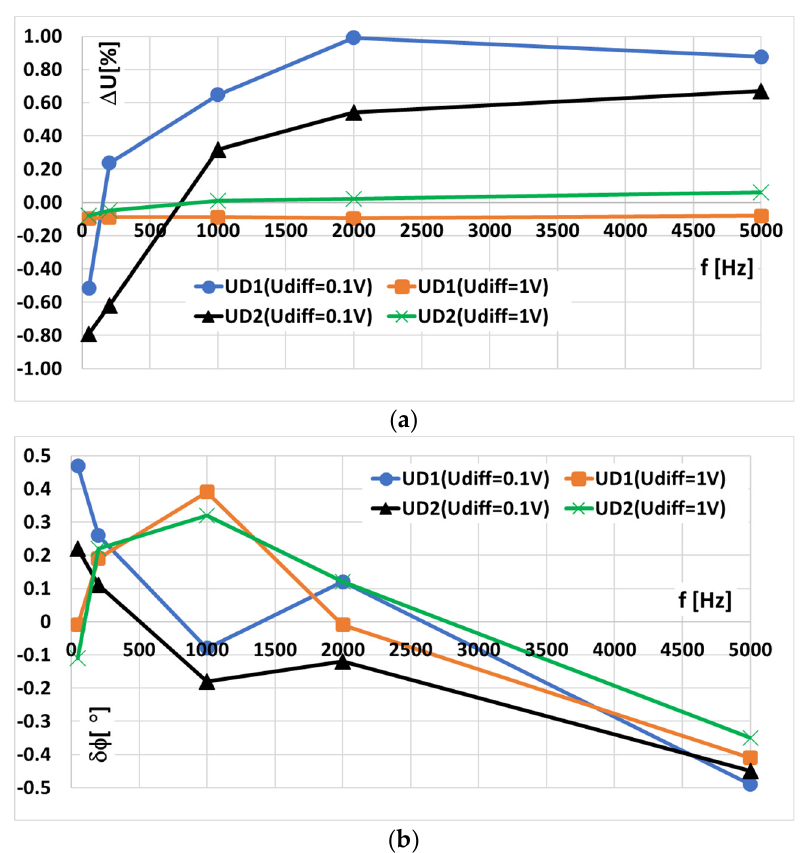
Figure 5. ( a ) The 1st and the 2nd opto-isolation circuits’ conversion ratio errors under operation with an additional common voltage divider. ( b ) The 1st and the 2nd opto-isolation circuits’ conver- sion phase error under operation with an additional common voltage